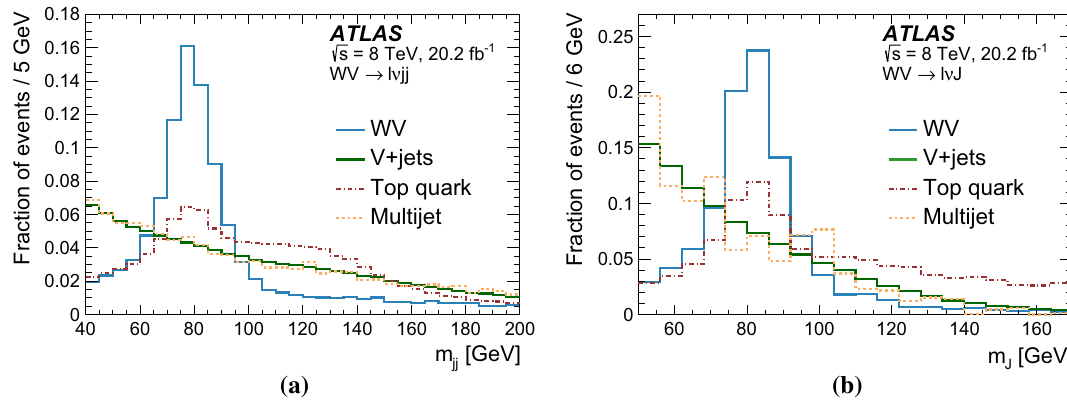
Fig. 2 The shapes of a the predicted m jj distributions in the WV → (cid:4)ν jj signal region and b the predicted m J distributions in the WV → (cid:4)ν J signal region, for the signal (peaked near 80 GeV) and various background processes. The distributions are normalized to unity